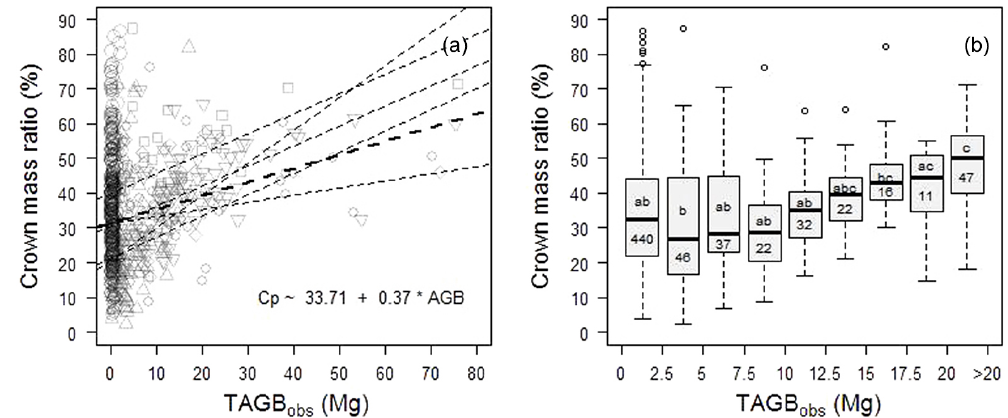
Figure 1. Panel (a) : distribution of crown mass ratio (in %) along the range of tree mass (TAGB obs , inMg) for 673 trees. Dashed lines represent the fit of robust regressions (model II linear regression fitted using ordinary least square) performed on the full crown mass data set (thick line; one-tailed permutation test on slope: p value<0.001) and on each separate source (thin lines), with symbols indicating the source as follows: empty circles from Vieilledent et al. (2011; regression line not represented since the largest tree is 3.7Mg only); solid circles from Fayolle et al. (2013); squares from Goodman et al. (2013, 2014); diamonds from Henry et al. (2010); head-up triangles from Ngomanda et al. (2014); and head-down triangles from the unpublished data set from Cameroon. Panel (b) : variation in crown mass ratio (in %) across tree mass bins of equal width (2.5Mg). The last bin contains all trees ≥ 20Mg. The number of individuals per bin and the results of nonparametric pairwise comparisons are represented below and above the median lines, respectively.